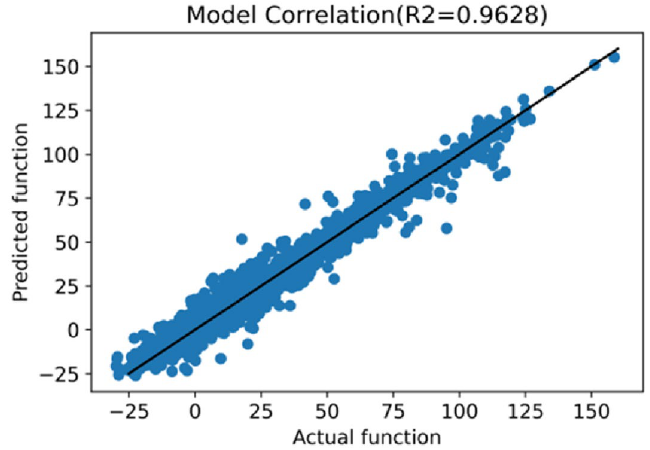
Fig. 12 Prediction vs actual for 5 variable function with